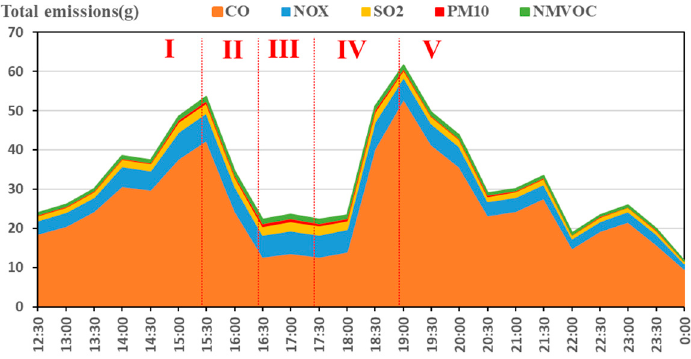
Figure 7. Dynamic variance of daily traffic flow total emissions on Minnesota freeway.